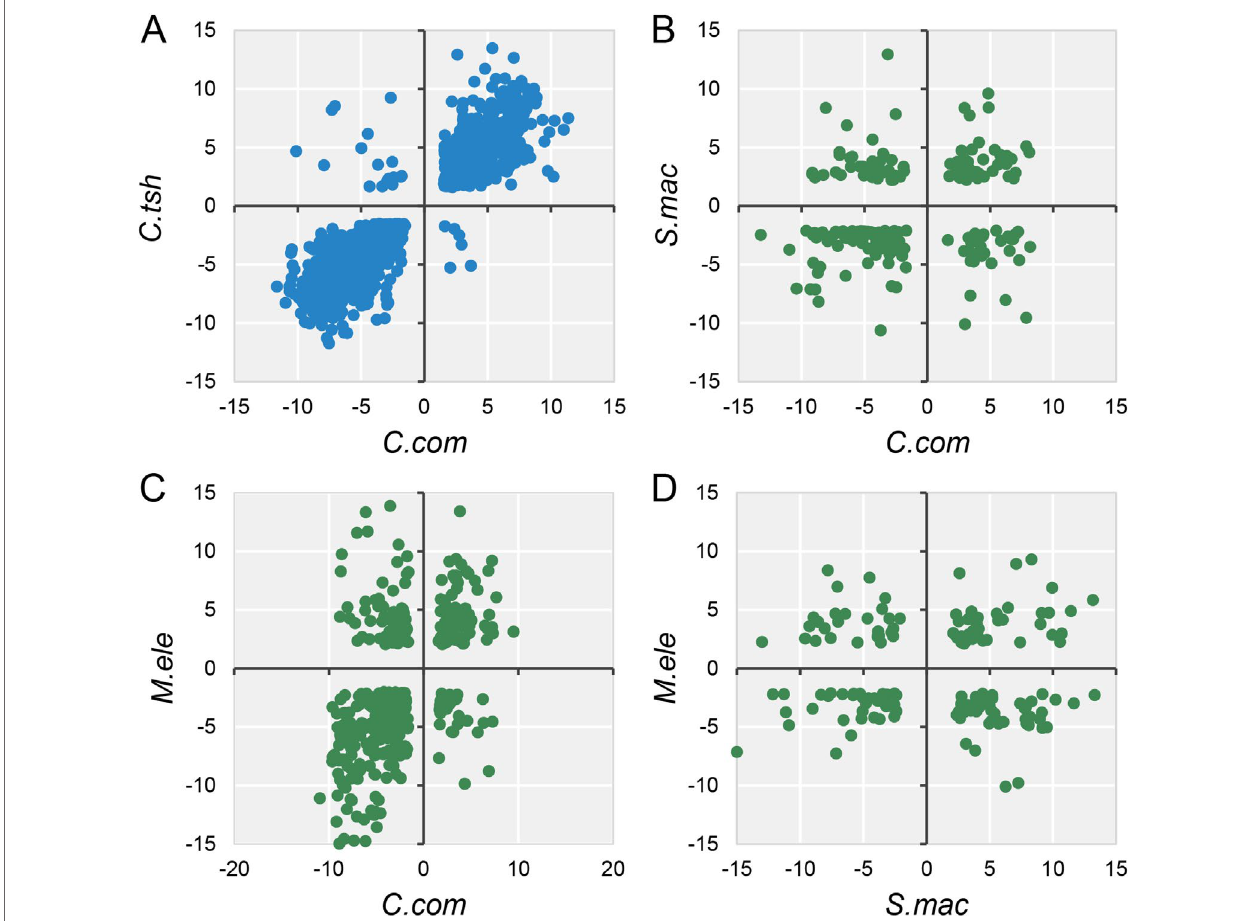
FIGURE 4 | Log2 fold expression change correlation between different species. The dots mean the expression fold change between EO and SM of DEGs (FDR ≤ 0.05 and FC ≥ 2) in any two species, and quadrants 1 and 3 of the scatter graph exhibit the conserved directionality of differential expression (both species in the EO exhibit higher expression or both species in SM exhibit higher expression) compared to one another. Blue (A) and green (B , C , and D) dots indicate intra-lineage and inter-lineage species comparisons, respectively. Here we only selected four representative comparisons to be shown, and the others are shown in Figure S7